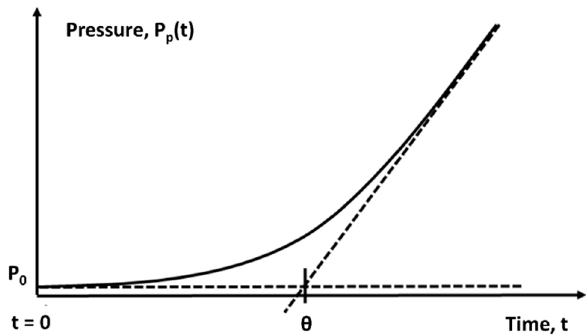
Figure 3. Schematic time dependence of the pressure under the membrane during the experiment.